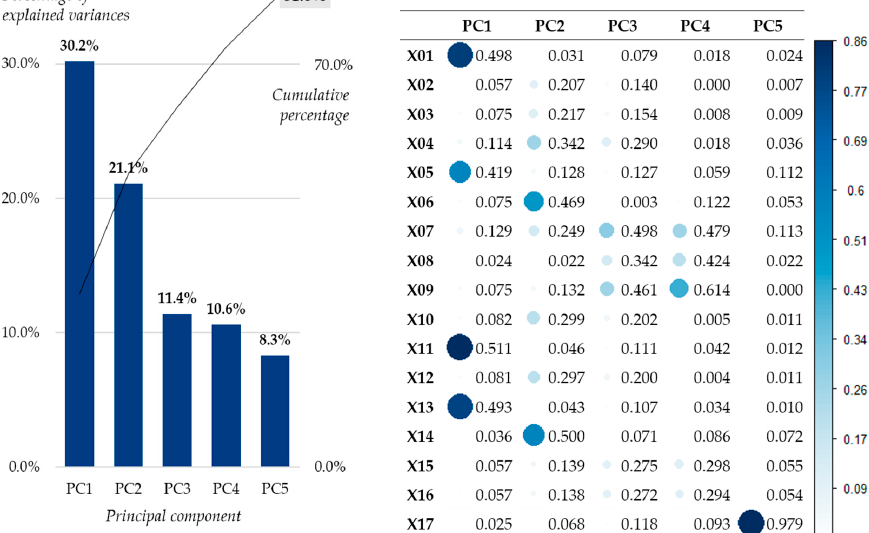
Figure 5. The first main component (PC1) explains the existing variable by 30.2% and PC2 by 21.1%, and up to PC5, 81.63% of the existing variable can be explained and summarized into five independent variables.